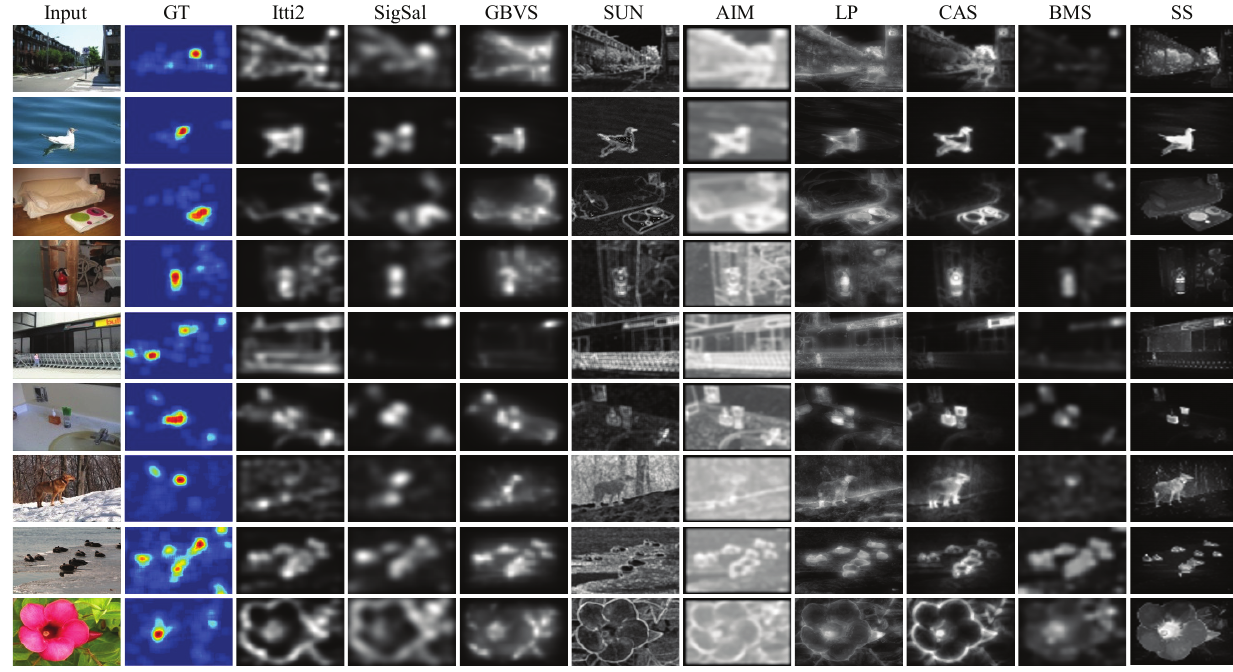
Figure 5. Comparison of saliency maps from nine methods on three benchmark eye movement datasets. The first two columns are the sample images and their fixation